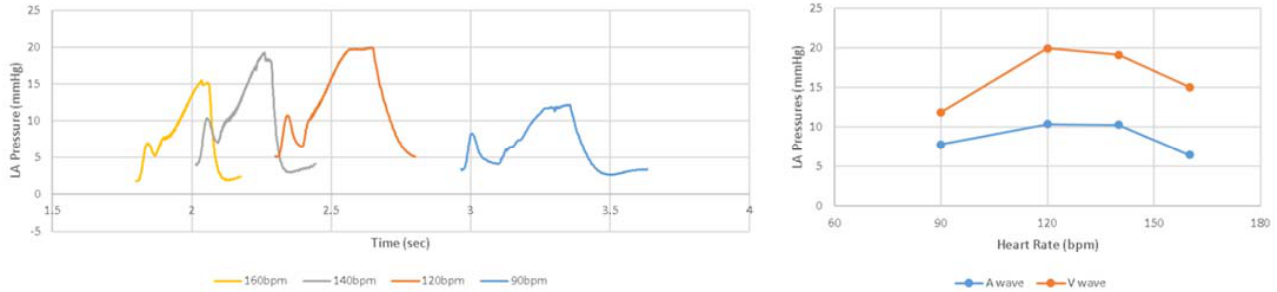
Figure 3. (Left) Pressure time traces for left atrium at the fifth cardiac cycle, as well as ( Right ) magnitudes of A wave and V wave left atrium pressures for simulations of heart rate related to exercise at 90 and 160 beats per minute.